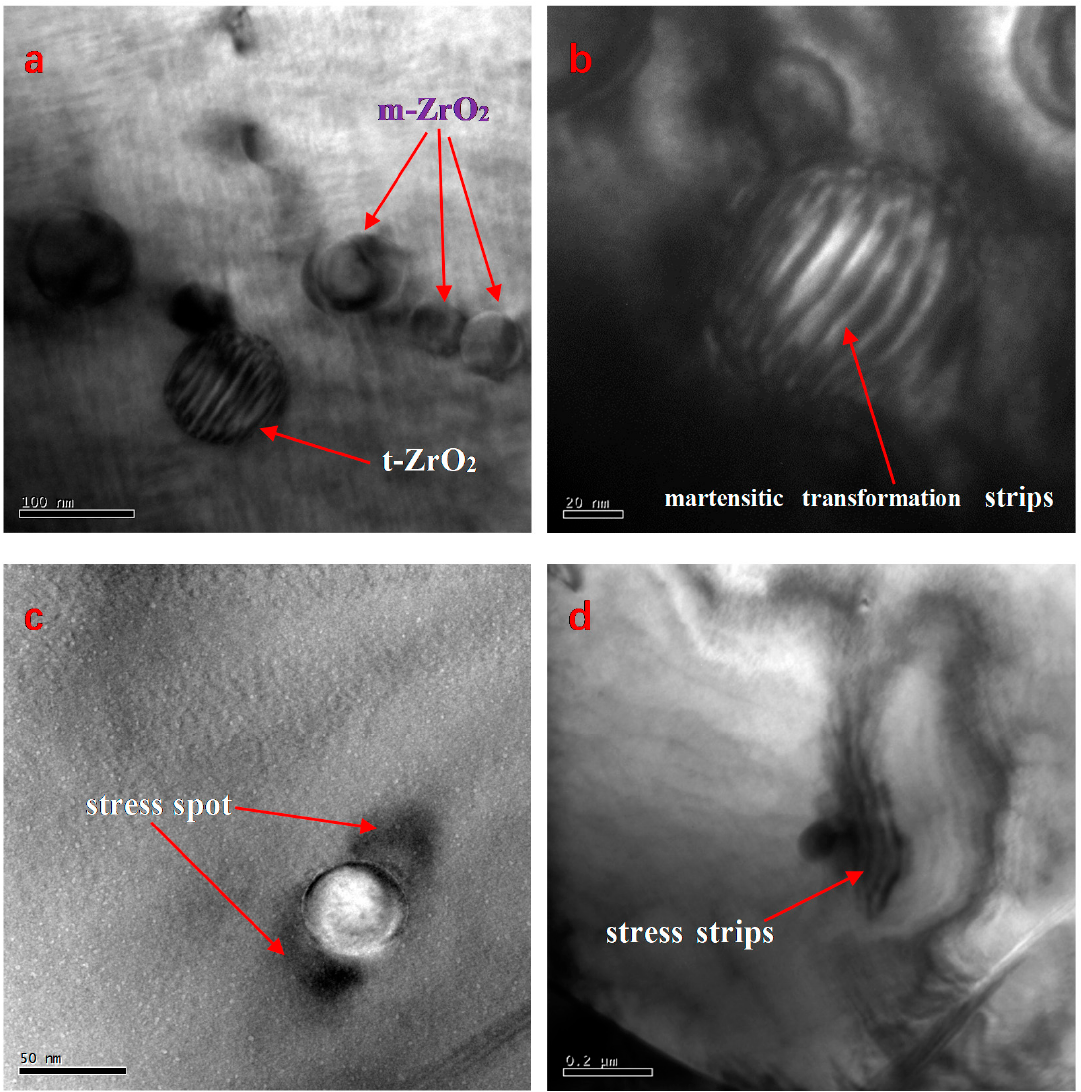
Figure 6. TEM images of the PZTN ( x = 0.04) composite ceramic sintered at 1260 °C for 2 h. ( a ) Intragranular monoclinic and tetragonal ZrO 2 spheres; ( b ) Dark-field image of martensitic transformation (striped pattern); ( c ) Stress spots around a ZrO 2 sphere; ( d ) Stress stripes around a ZrO 2 nanoparticle.